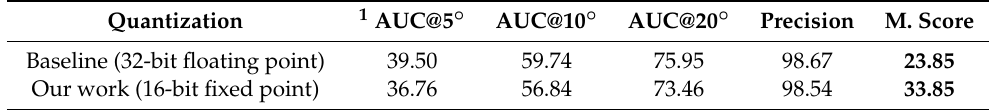
Table 4. Matching